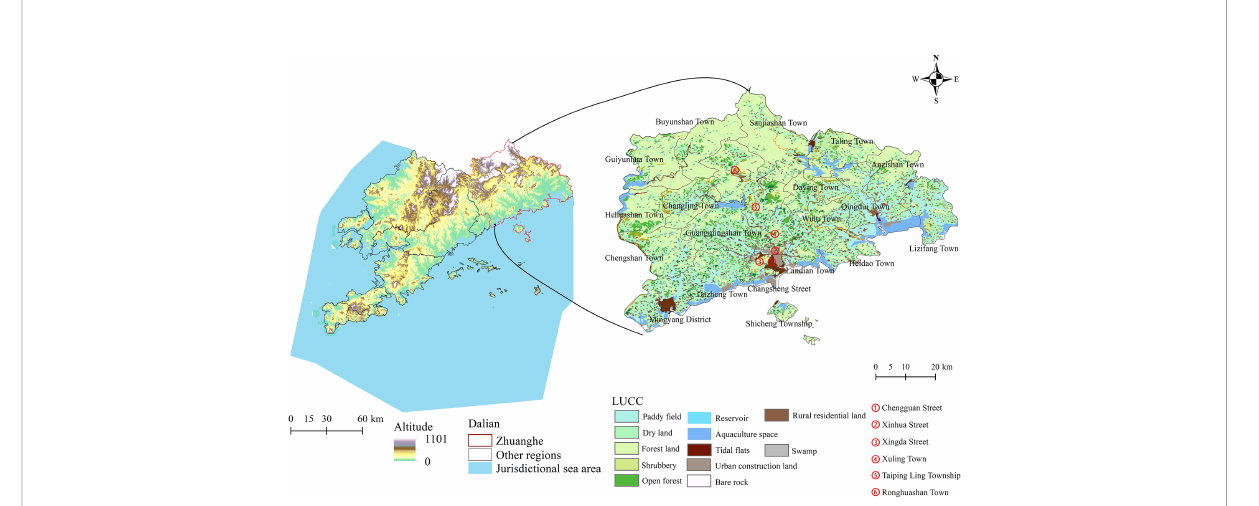
FIGURE 2 Schematic diagram of the study area location. LUCC, land-use and land-cover